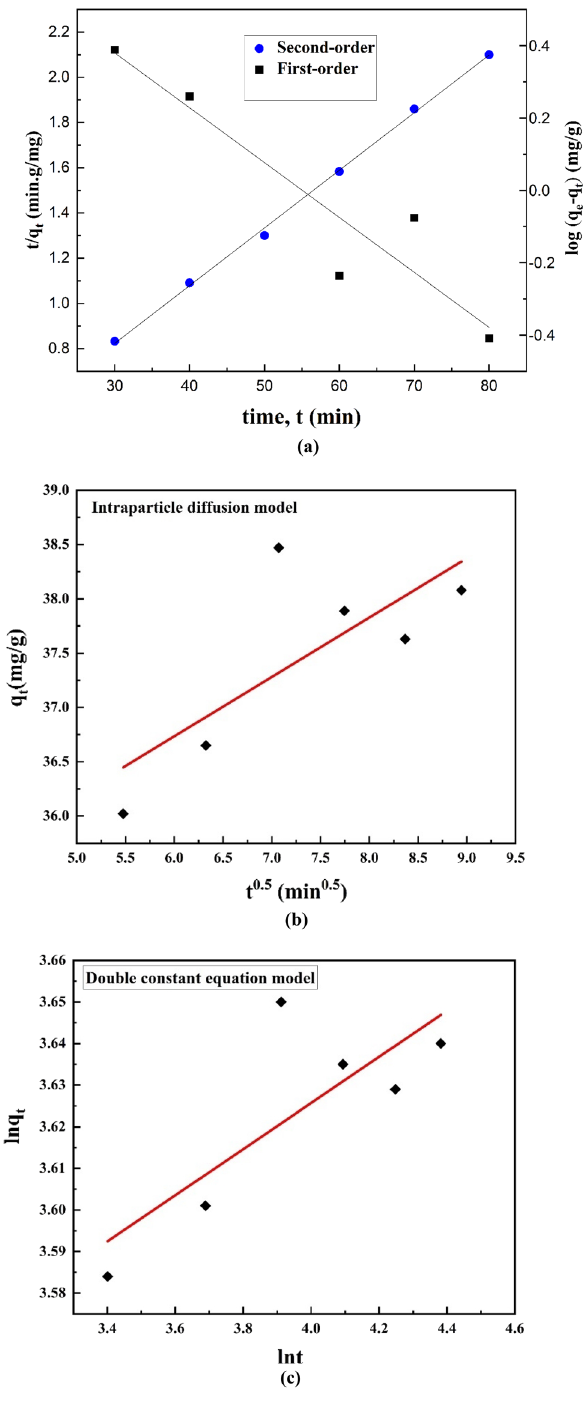
Figure 8. Linear fitting curves of adsorption kinetics. ( a ) Pseudo-first-order and pseudo-second-order kinetics models, ( b ) intraparticle diffusion model, and ( c ) double constant equation model for adsorption of Cd(II) onto HAp/bentonite